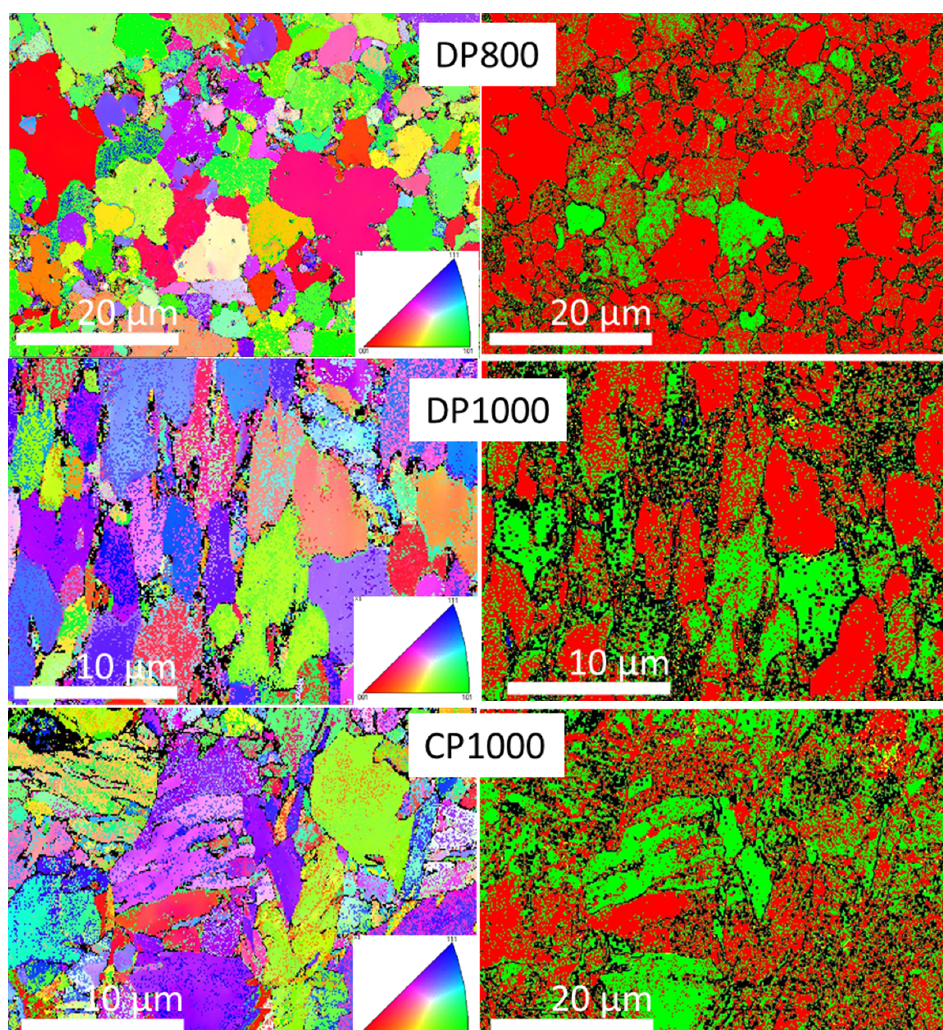
Figure 6. EBSB analysis of surface microstructure of DP800, DP1000, and CP1000. Inverse pole figures are given in the left column whereas phase indexation is shown in the right column (yellow cementite, green martensite, red ferrite, blue austenite, green martensite).